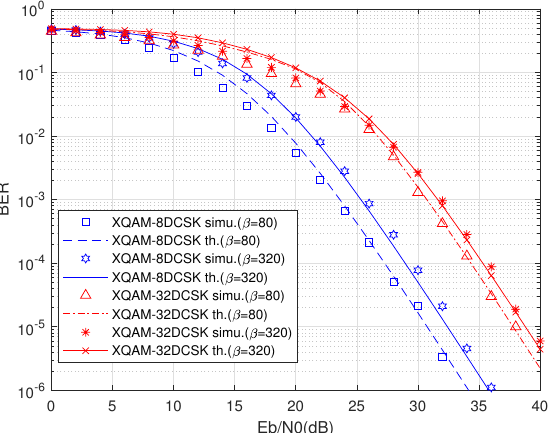
Figure 3. Theoretical and simulated BER performance of the proposed XQAM- M DCSK system over a multipath Rayleigh fading channel.